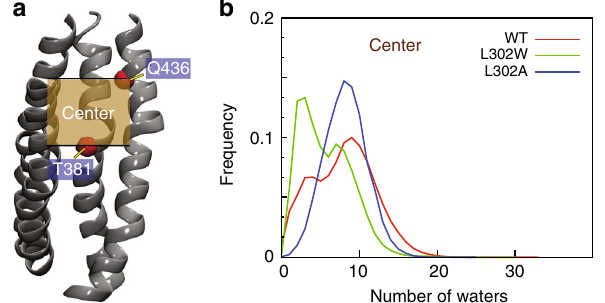
Fig. 4G – I, P – R, S – T). Rearrangements of TM4 that lead to groove occlusion require the reorganization of interactions that can stabilize various conformations available to the fl exible portions of this TM.